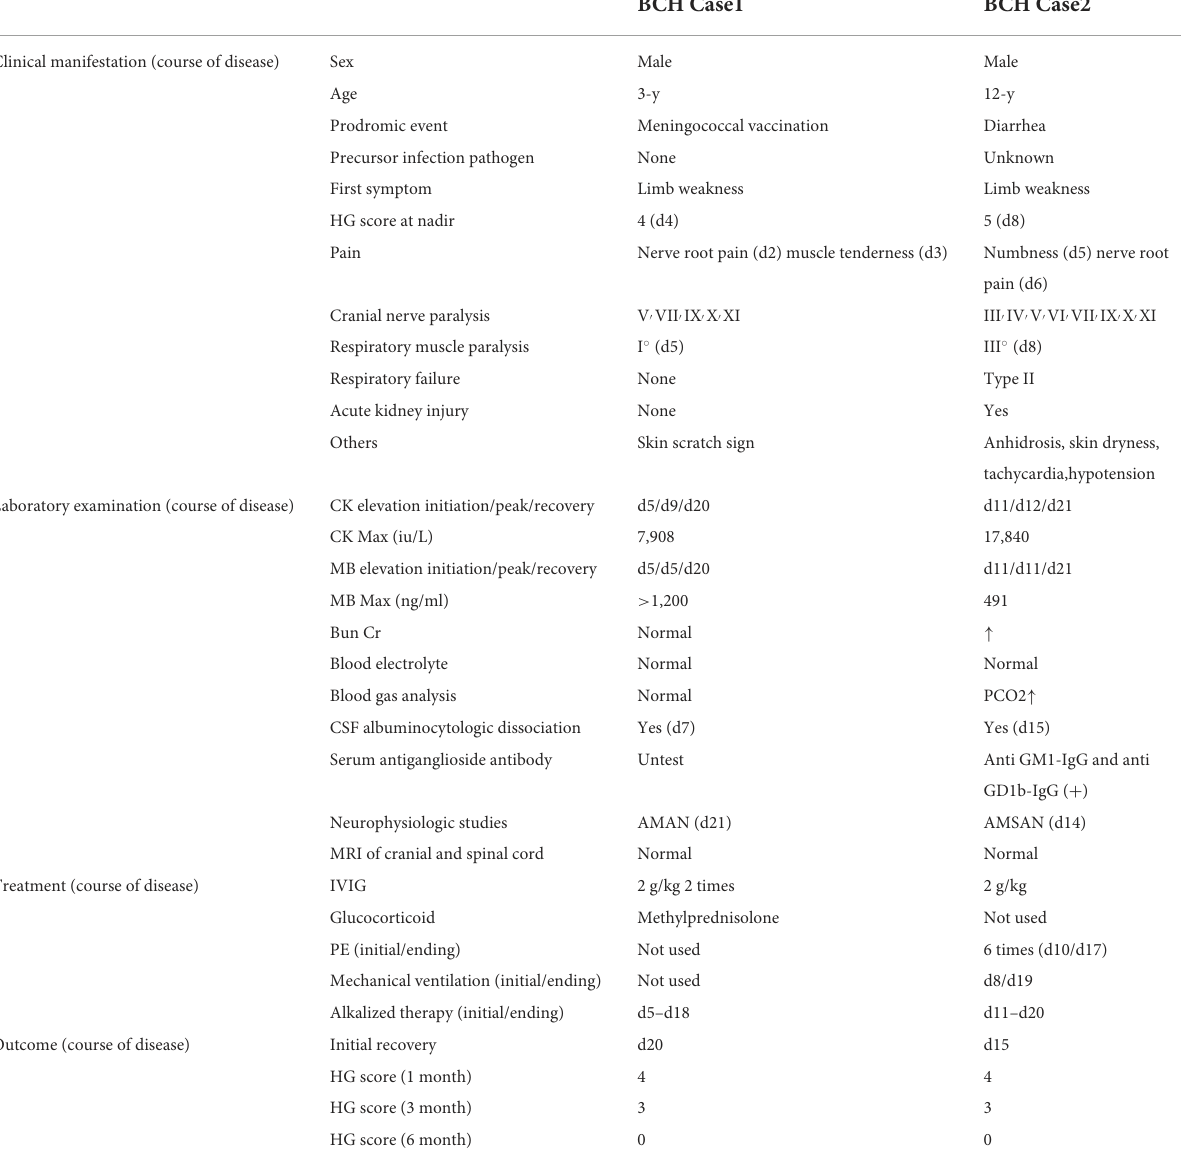
TABLE 1 Clinical manifestation, laboratory examination, treatment and outcome of